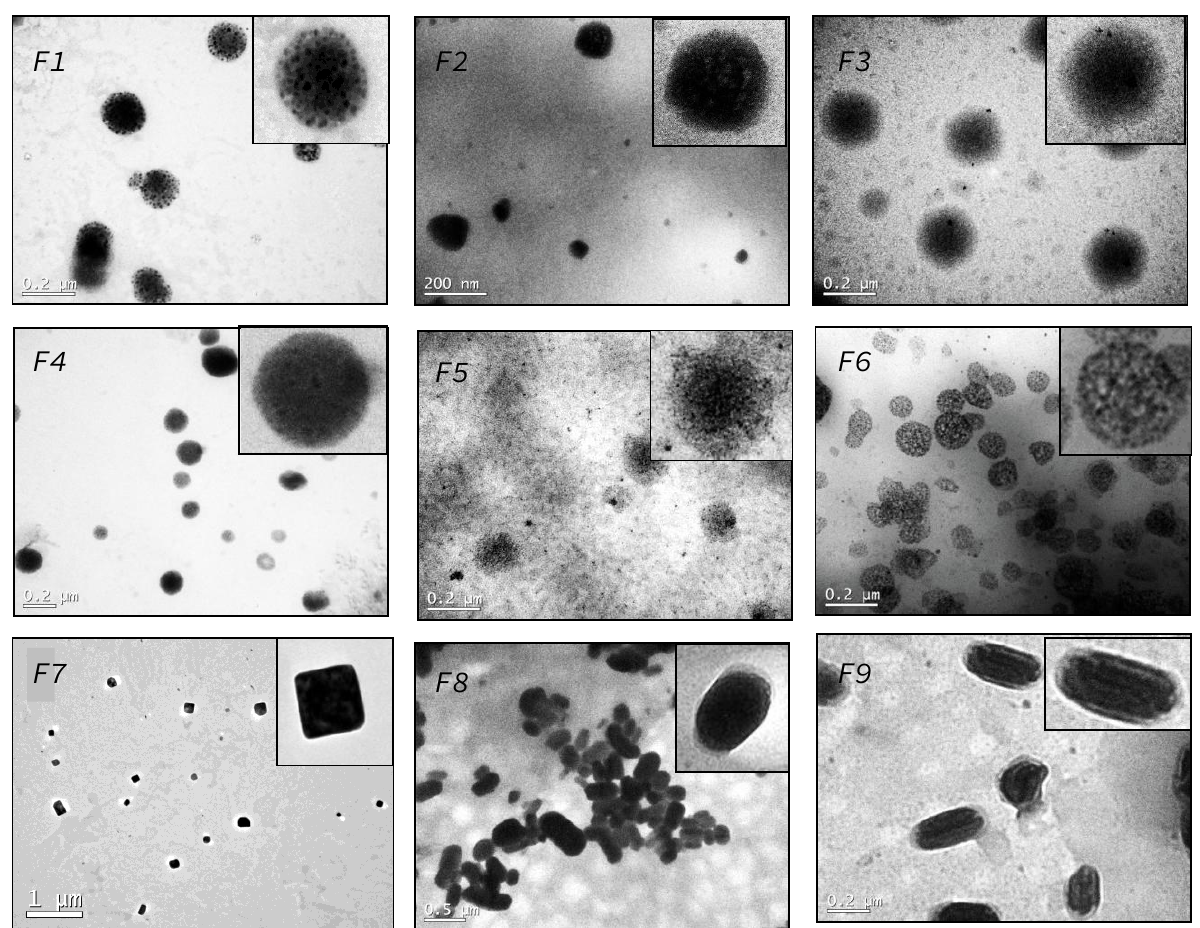
Figure 1. Representative transmission electron microscopic (TEM) images of